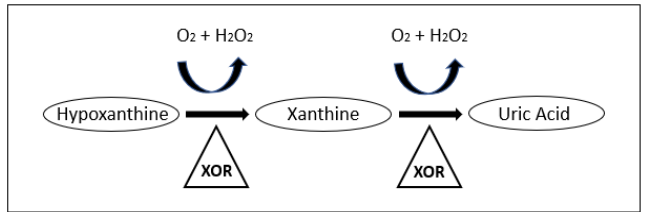
Figure 1. Purine metabolism pathway leading to the production of Uric acid [97]. Reproduced